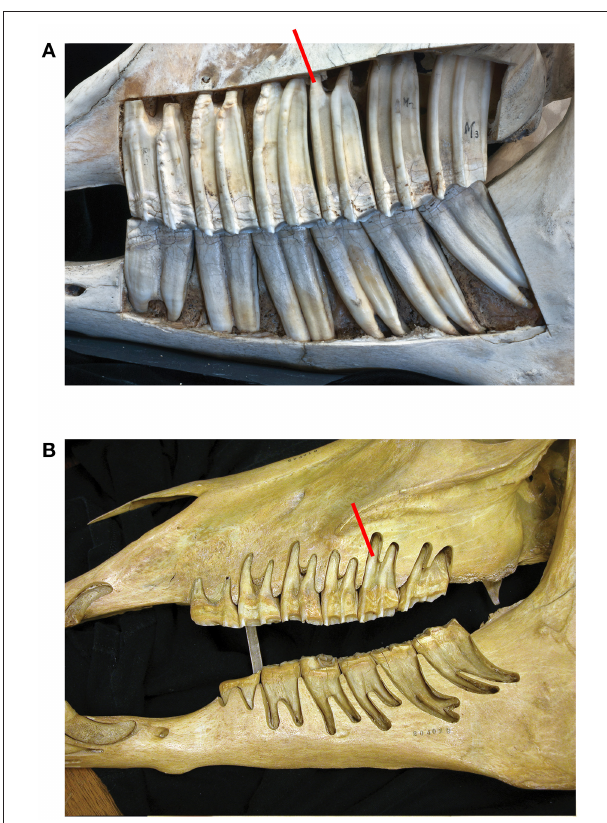
FIGURE 1 | (A) In Equus caballus NHMBa 28, extreme hypsodonty is observed; all six teeth (three premolars and three molars) are approximately equally hypsodont. The maxilla and mandible have been cut open to show the crown contained in the alveoli. The active crown is the exposed part. Red square shows the roots which are short and open-ended. (B) An old Equus individual AMNH 204019. The enamel crowns have been almost totally worn out. In this specimen, the roots are longer than in younger horses and closed. Root increase is most likely an epigenetic response to the reduction of the height of the crown which transmits increased forces. The pressures of mastication change and that induces the roots to grow